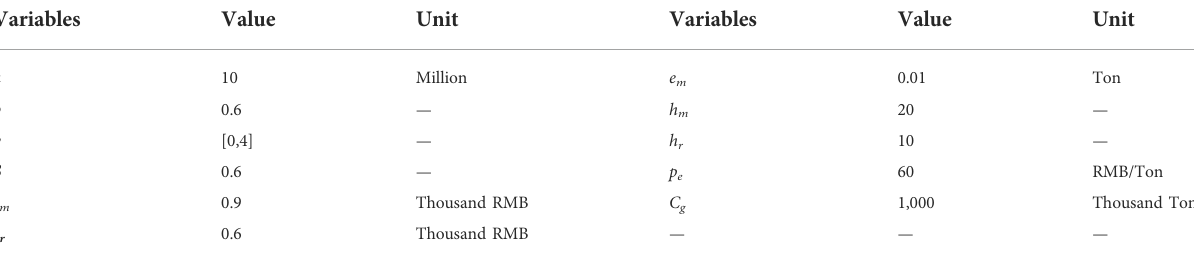
TABLE 2 Input parameters of the simulation.